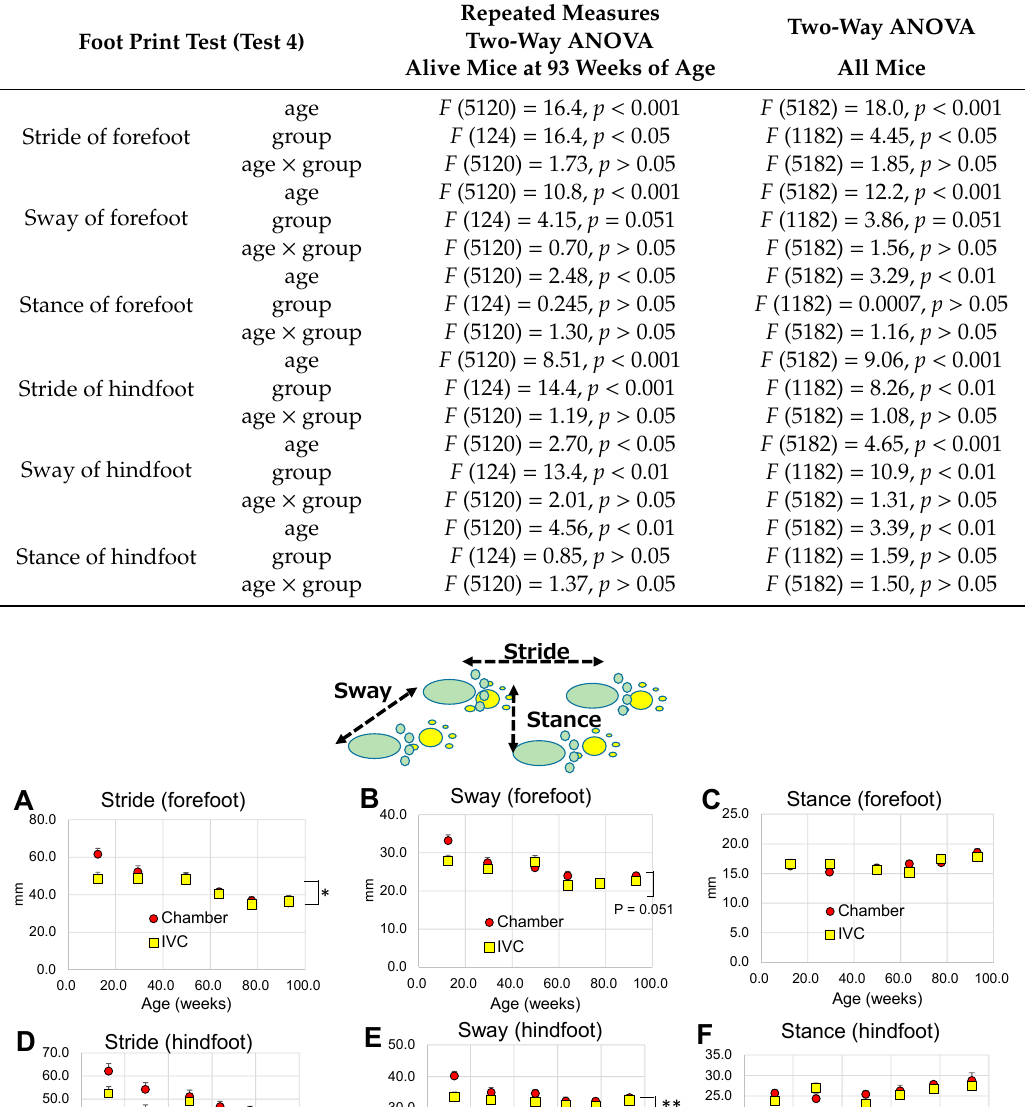
Table 2. Results of statistical analysis in Test 4.